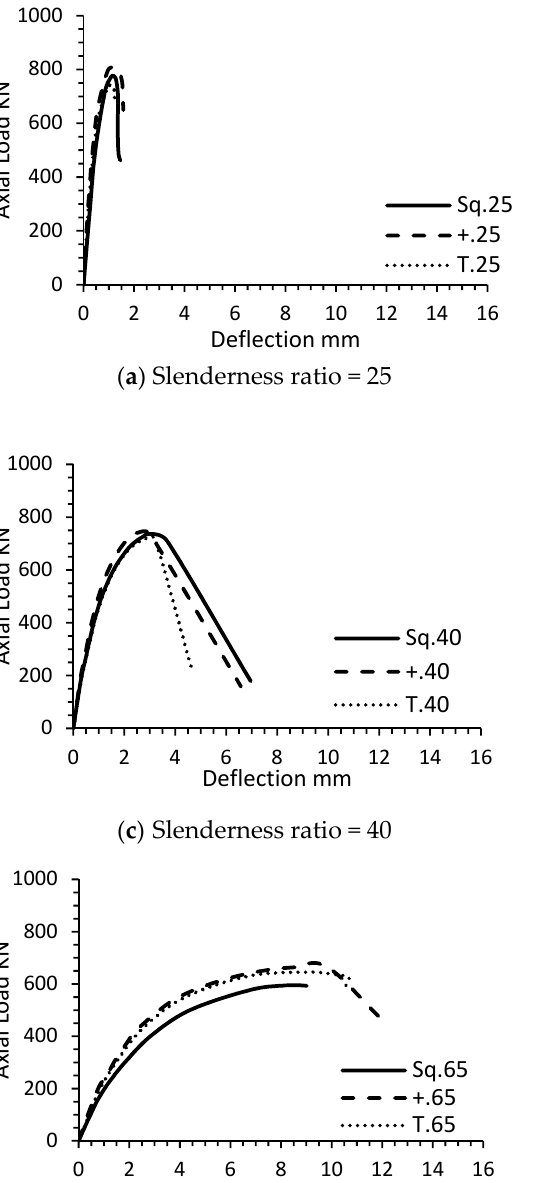
Figure 8. Influence of increased slenderness ratio (SR) on load-deflection curves of specimens.